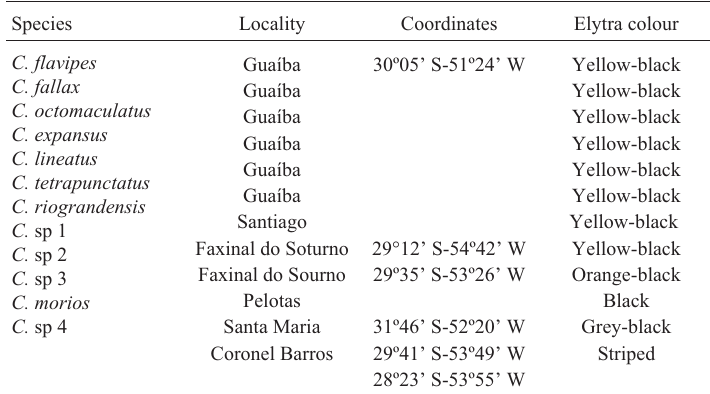
Table 1 - Chauliognathus species, locality of collection, and elytra colour